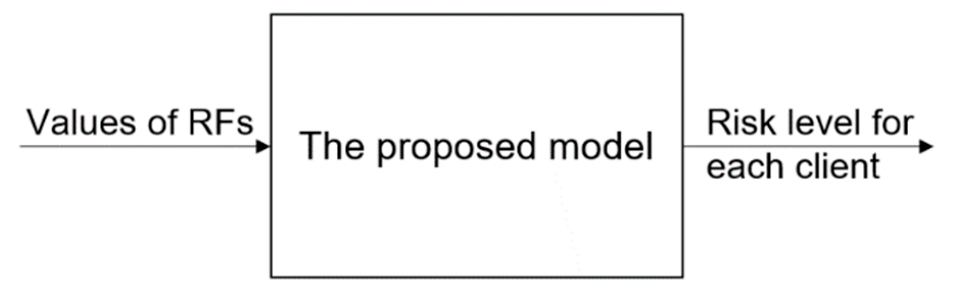
Figure 1. Black box form of the considered problem.